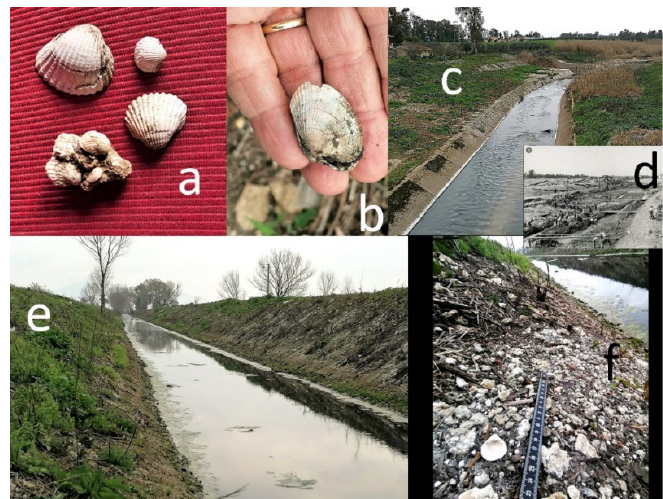
Figure 14. ( a ) Cerastoderma edulis sampled in a section outcropping in the channel of this figure in ( e ); ( b ) Tapes decussatus from the outcrop on the reclamation drainage c channel; ( c , e ) the channel ( d ), the Mussolini channel during the excavation in the 1930s; ( f ) the outcrop Nassa mutabilis Tapes decussatus,